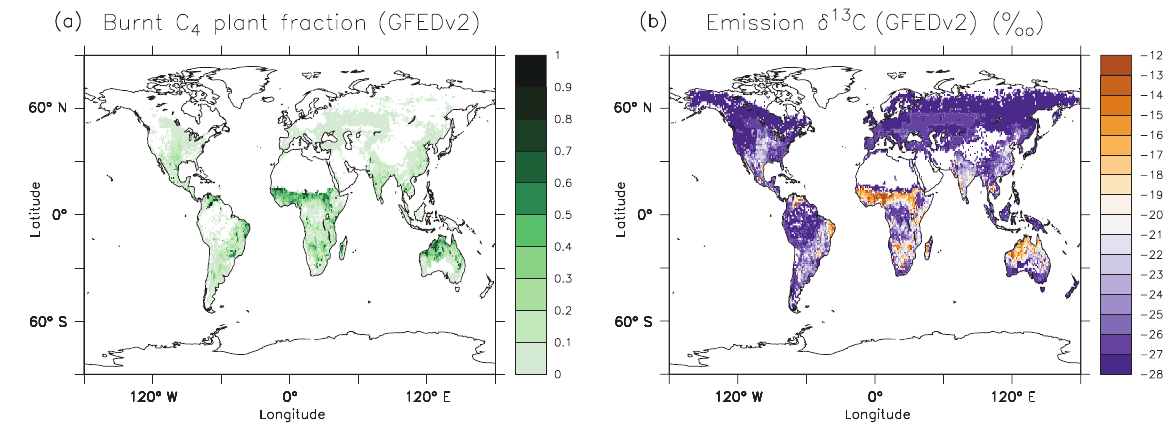
Figure 3. Burnt biomass C 4 plant fraction (a) and corresponding isotopic signature of the emitted carbon (b) from the GFED v2.1 database. Fields are climatological yearly averages (see text, also Fig. 4).